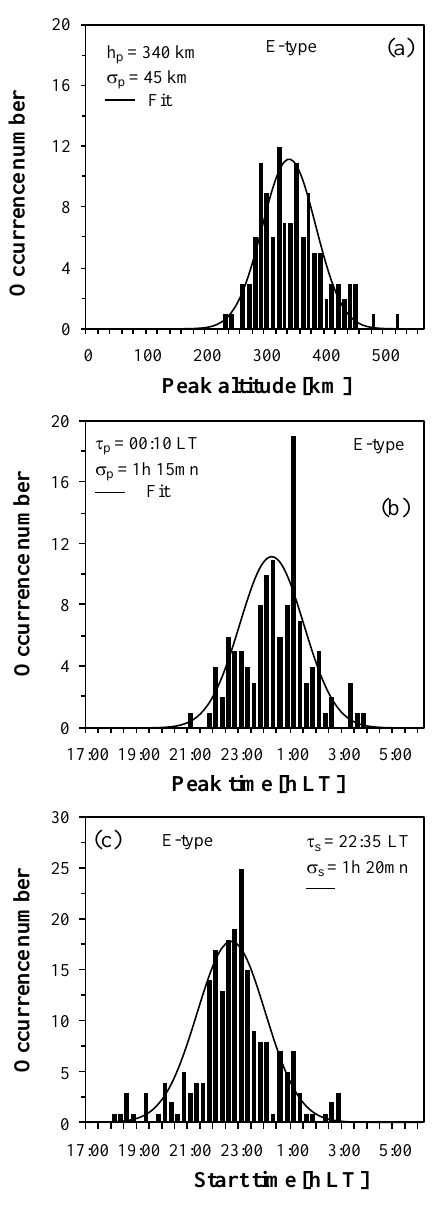
Figure 9. Statistical distributions of the characteristic parameters of the height peak of phase III in the northern summer period: (a) shows the altitude h III p at the maximum, (b) the instant τ III p at the maximum and (c) the instant τ III s at the start. The solid line in each panel represents the fits of the data to the probability density func- √ e − (x − m) 2 / 2 σ 2 , in which x denotes the parameter tion p(x) = 1 σ 2 π h III p , τ III p or τ III s , m its most probable value, and σ the corresponding dispersion parameter.